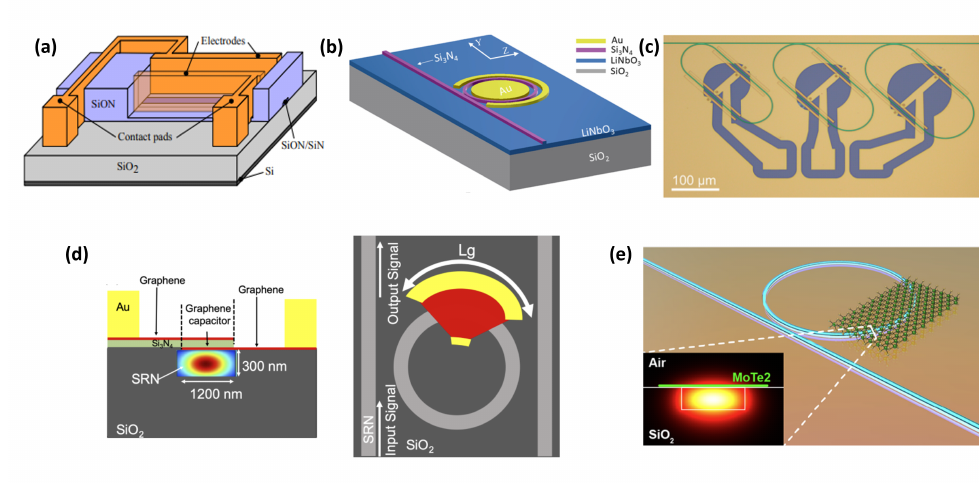
Figure 7. ( a ) Three-dimensional schematic of EO-polymer integrated in SiN-SiON platform; repro- duced from [82] under a CC BY 4.0 license. ( b ) Schematic of the tunable hybrid SiN-LN microring resonator; reprinted with permission from [83], ©2019 The Optical Society. ( c ) Top view of hybrid BTO-SiN racetrack resonator; reproduced with permission from [84], ©2019 American Chemical Society. ( d ) Schematic cross-section of the hybrid waveguides based on graphene capacitors and top view of a microring resonator partially covered by a graphene capacitor; reproduced from [85] under a CC BY 4.0 license. ( e ) Schematic of Si 3 N 4 ring resonator covered with monolayer-MoTe 2 ; reprinted with permission from [86], ©2021 American Chemical